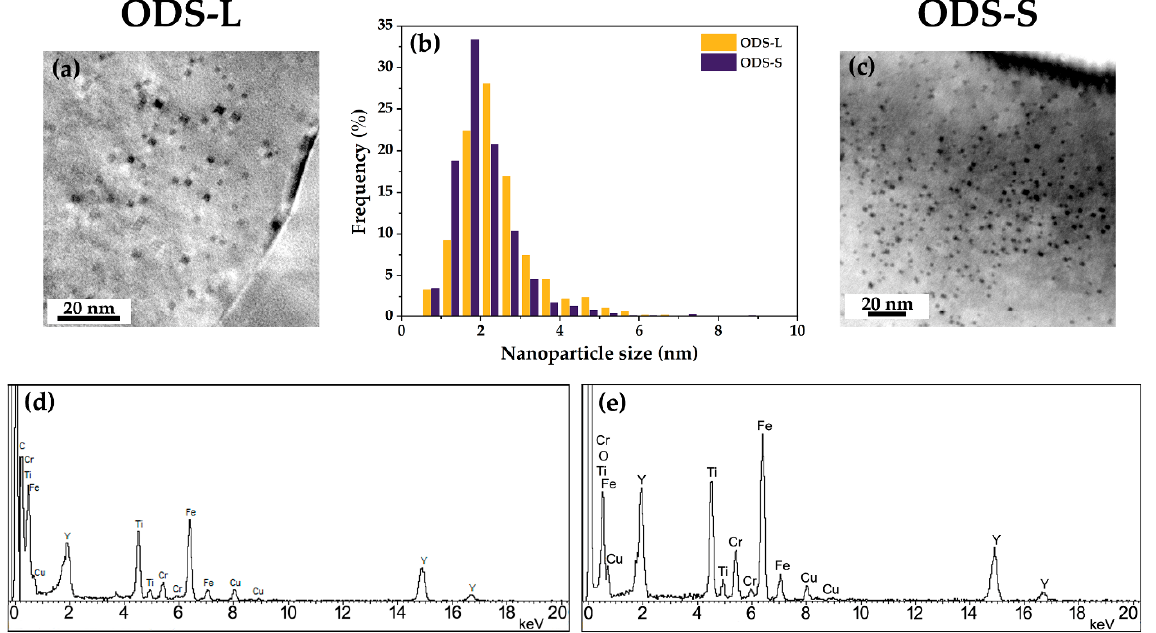
Figure 12. Y-Ti-O nanoparticles on ODS-L and ODS-S steel samples annealed at 1273 K after HCR: ( a , c ) BF-TEM micrographs, ( b ) particle size histogram, and (d, e ) TEM-XEDS analysis.